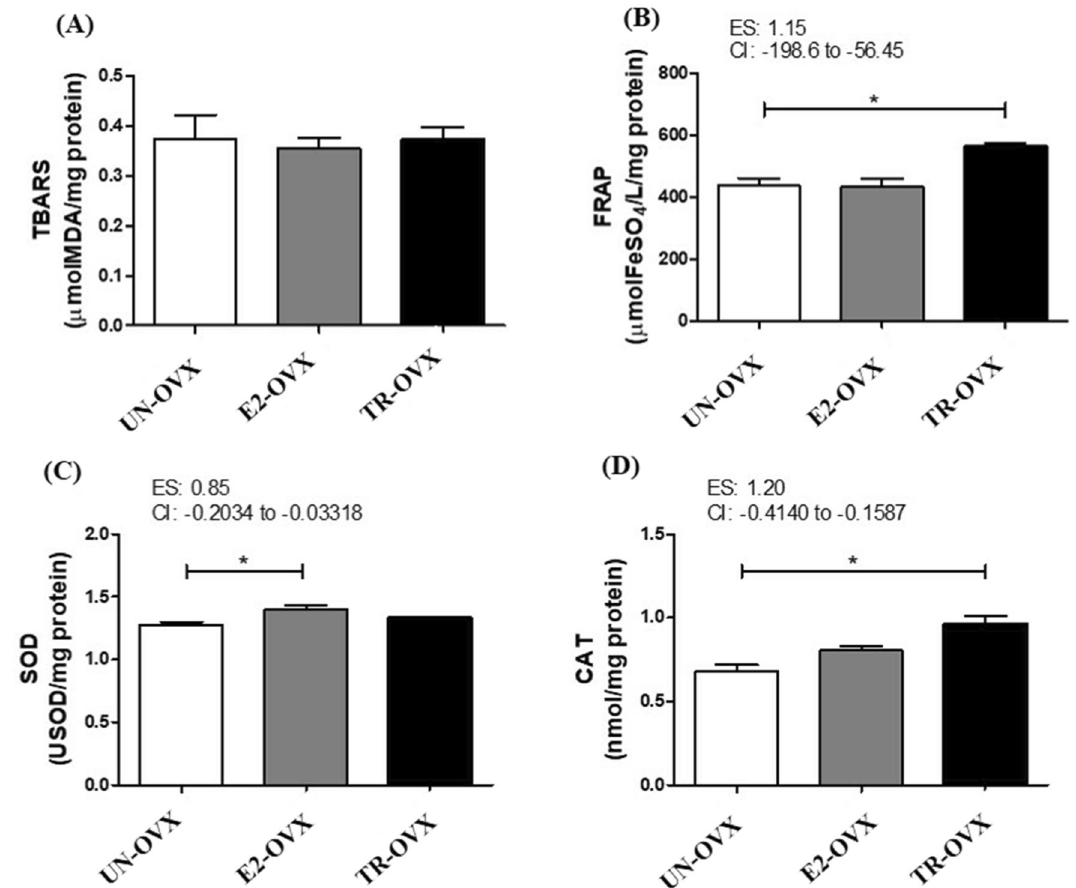
Figure 3. Redox status and antioxidant enzymes assays in the left soleus muscle of untrained ovariectomized rats (UN-OVX), ovariectomized rats treated with Estradiol replacement (E2-OVX), and trained ovariectomized rats (TR-OVX). ( A ). Thiobarbituric acid reactive substances assay (TBARS). ( B ). The ferric reducing ability of plasma (FRAP). ( C ). Superoxide dismutase activity (SOD). ( D ). Catalase activity (CAT). N = 10 per group. Data are reported as mean ± S.E.M. 95% confidence interval (CI). Effect size (ES) *p < 0.01. One-way ANOVA.